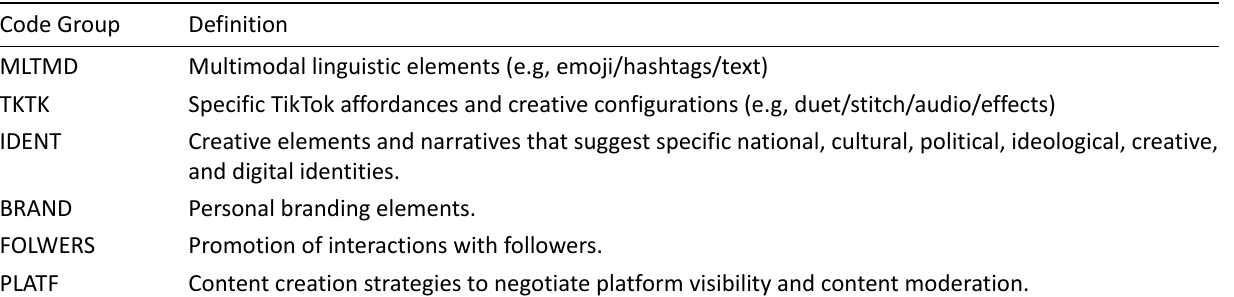
Table 2. Code groups for TikTok video content analysis.